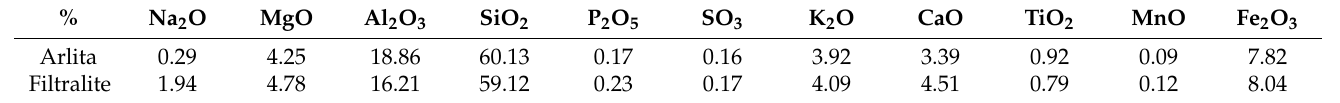
Table 2. Chemical composition of Arlita and